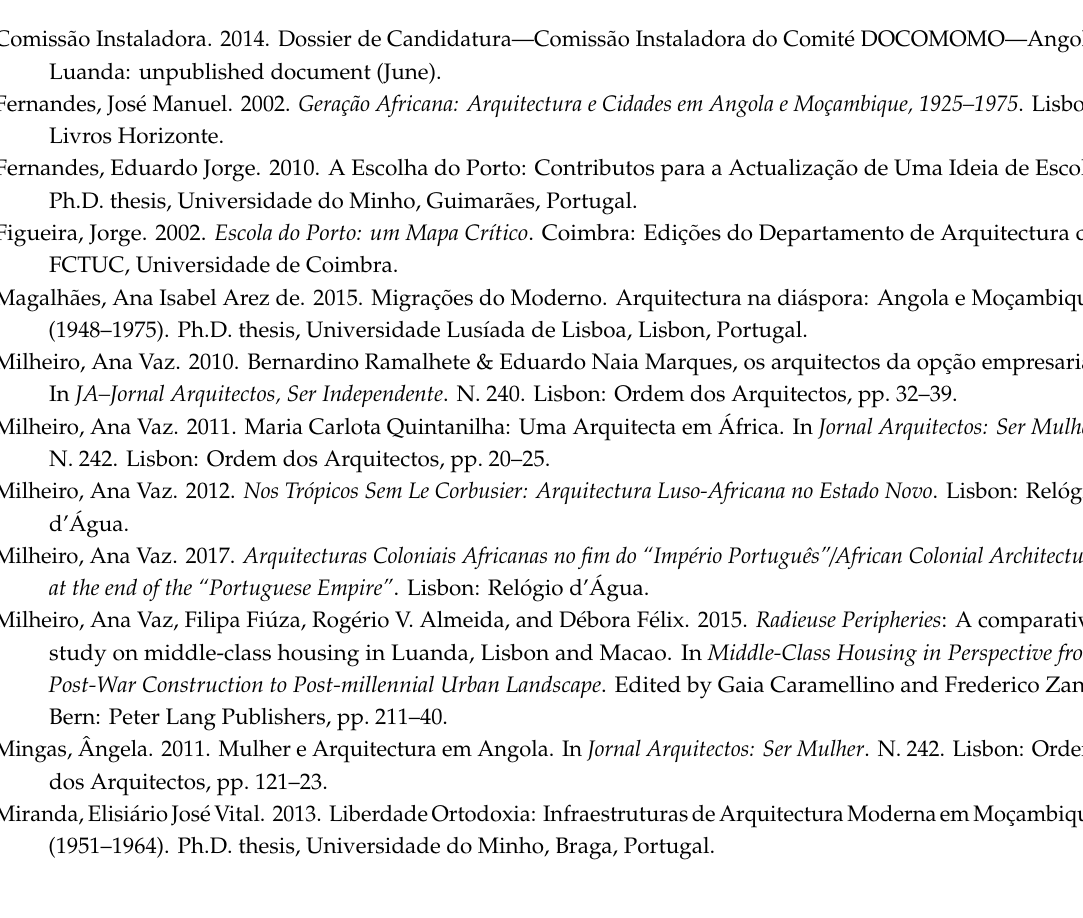
Figueira, Jorge. 2002. Escola do Porto: um Mapa Cr í tico . Coimbra: Ediç õ es do Departamento de Arquitectura